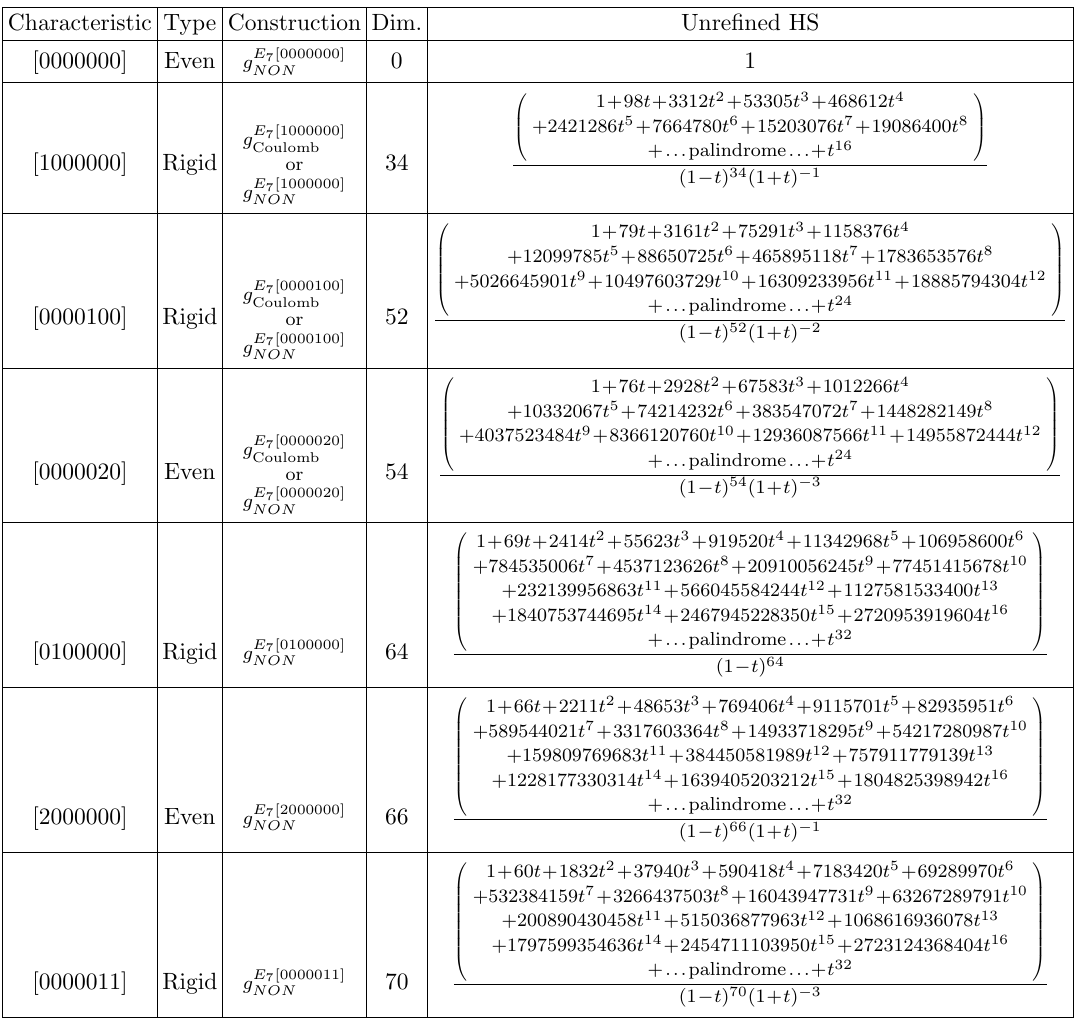
Table 18 . E 7 orbit constructions and Hilbert series